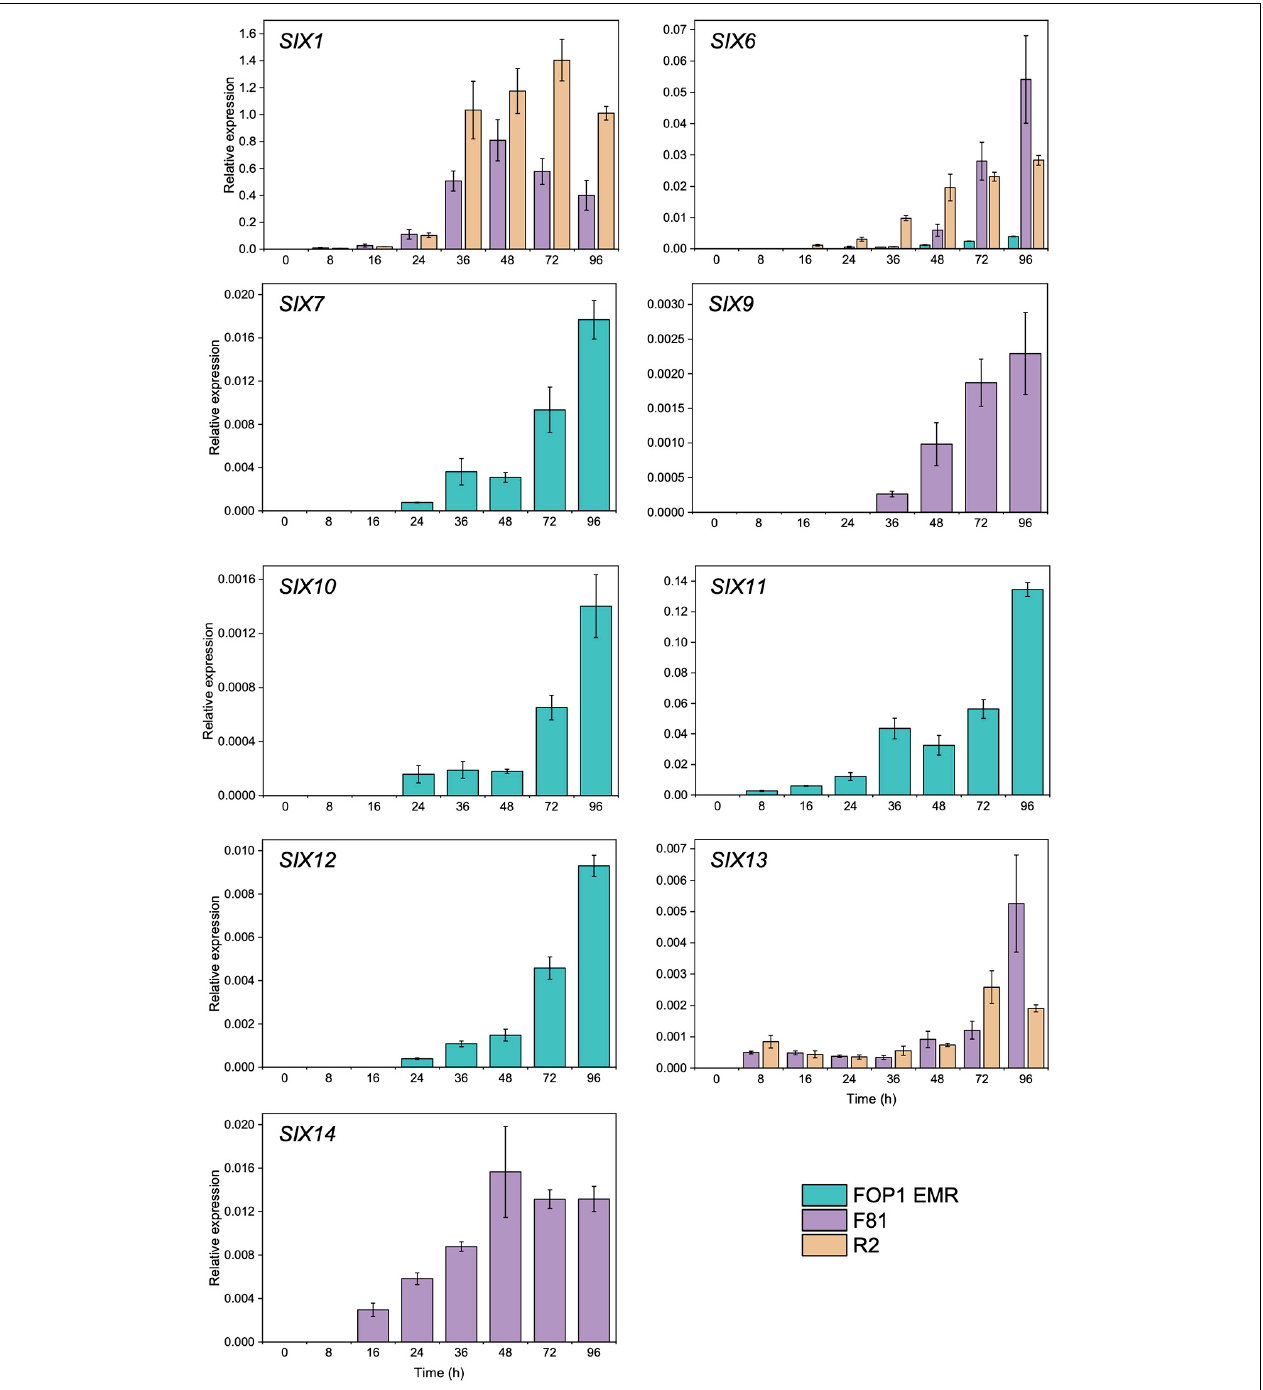
FIGURE 2 | Expression of Secreted In Xylem ( SIX ) genes in pea roots infected with FOP isolates FOP1 EMR (race 1), F81 (race 2), and R2 (race 2 S ) as determined by reverse transcription qPCR of RNA. Expression was calculated relative to the TEF and the mean value displayed [error bars represent Standard error of the mean